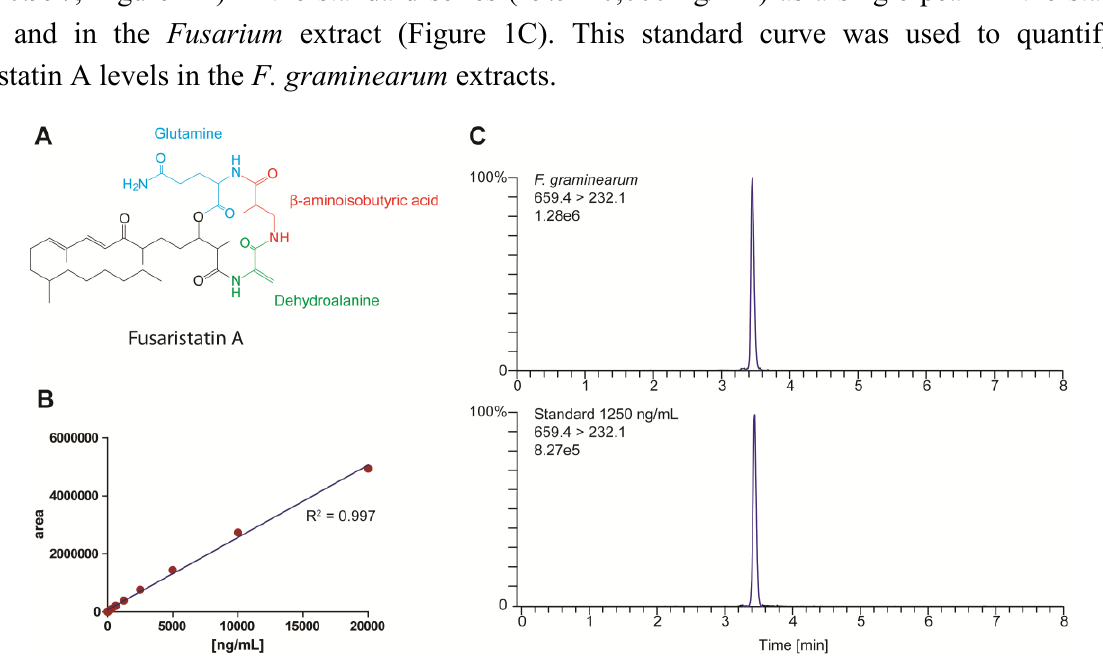
Figure 1. ( a ) Structure of fusaristatin A. ( b ) Standard curve of fusaristatin A in a twofold dilution series (19.5–20,000 ng/mL). ( c ) Chromatograms of fusaristatin A in reference